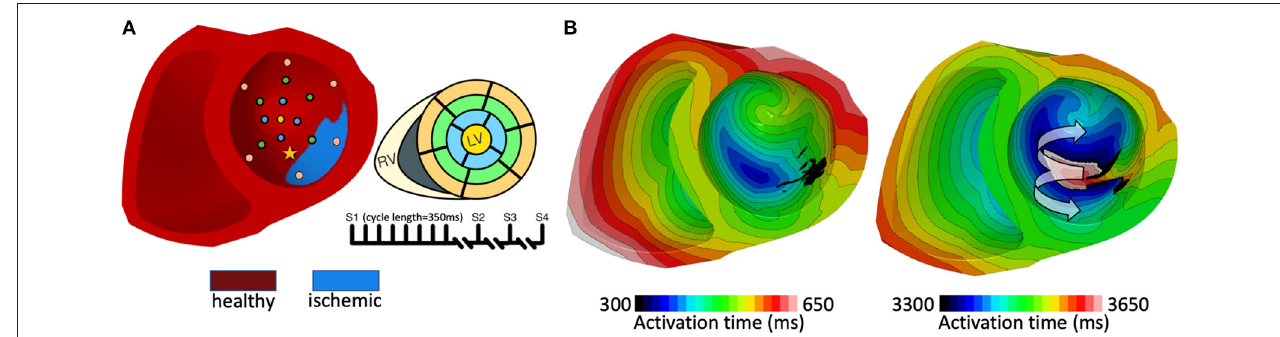
FIGURE 2 | (A) Pacing induced arrhythmia protocol. The figure shows pacing sites on the myocardium (left), a schematic of corresponding AHA segments (top right) and pacing intervals (bottom right). Each stimulus had a duration of 10 ms, current amplitude of 100 uA/cm 2 and electrode volume of 1 mm 3 . (B) Activation maps during a pacing train that resulted in induction of a sustained reentrant circuit. The stimulus was delivered near the ischemic border. Black region denote myocardium located deep within the ischemic tissue that did not excite due to the severity of the remodeling.